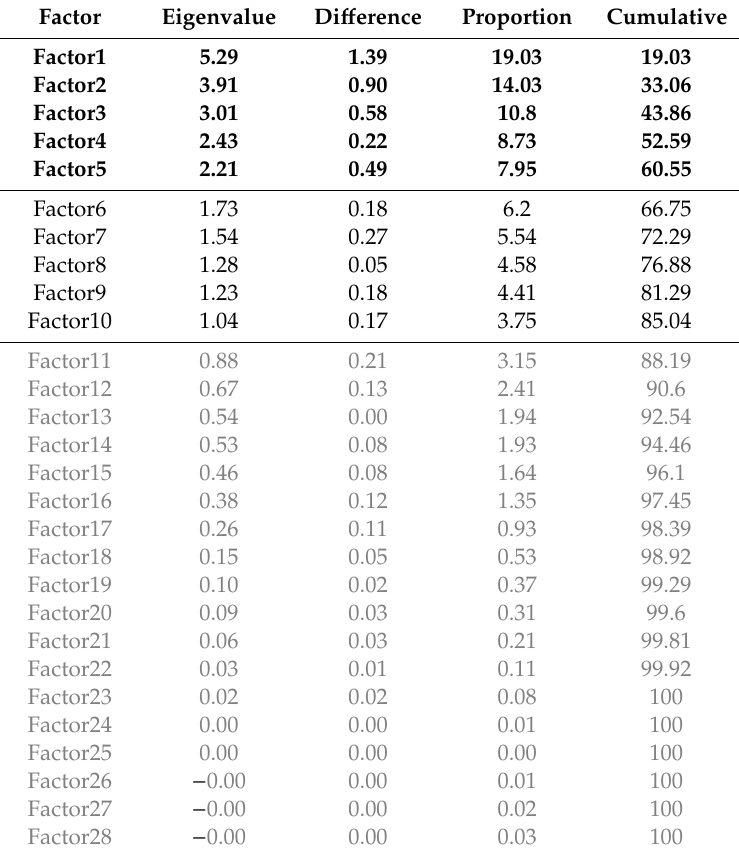
Table 3. Total variance and percentage of individual factors. Results of factor analysis